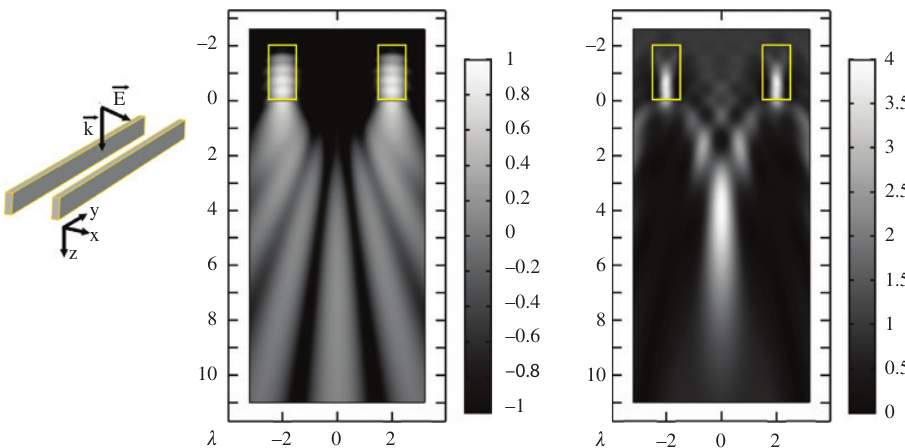
Figure 2: Calculated intensity patterns generated by a pair of dielectric rectangular structures (W = λ , H = 2 λ , spacing D = 4 λ , n = 1.4 in air with an incident plane wave (in-plane polarization). Left: scattered intensity pattern (logarithm scale). Right: diffraction intensity pattern resulting from the interference of the scattered field with the incident field (linear scale). The spatial scales are normalized to λ